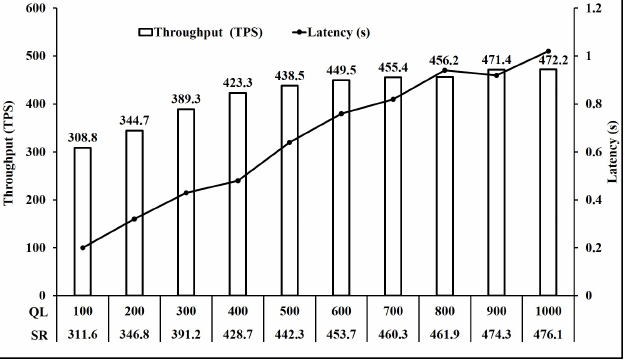
Figure 7. Operations with two write key operations (Queue Length: QL, Send Rate (TPS):